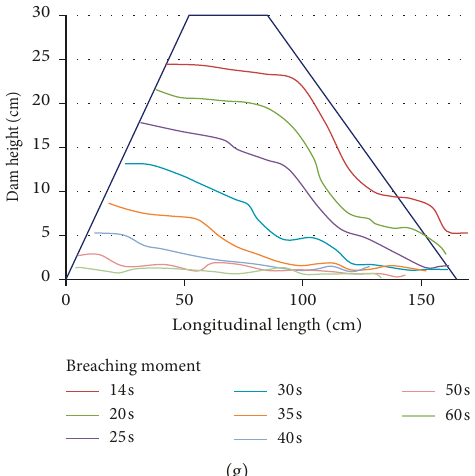
Figure 8: Longitudinal profiles of the dam during failure process for different channel bed slopes at different times. (a) Bed slope of 1 ° . (b) Bed slope of 2 ° . (c) Bed slope of 3 ° . (d) Bed slope of 7 ° . (e) Bed slope of 9 ° . (f) Bed slope of 11 ° . (g) Bed slope of 13 °